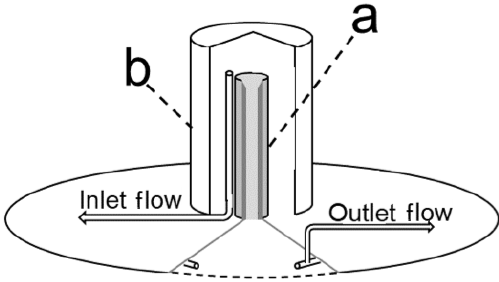
Figure 2. Illustration modified from Rayment and Jarvis (1997) de- picting the chamber lid with cutout to show the inlet tube (a) and the polyvinyl chloride (PVC) cap (b) . Inlet and outlet sampling points are